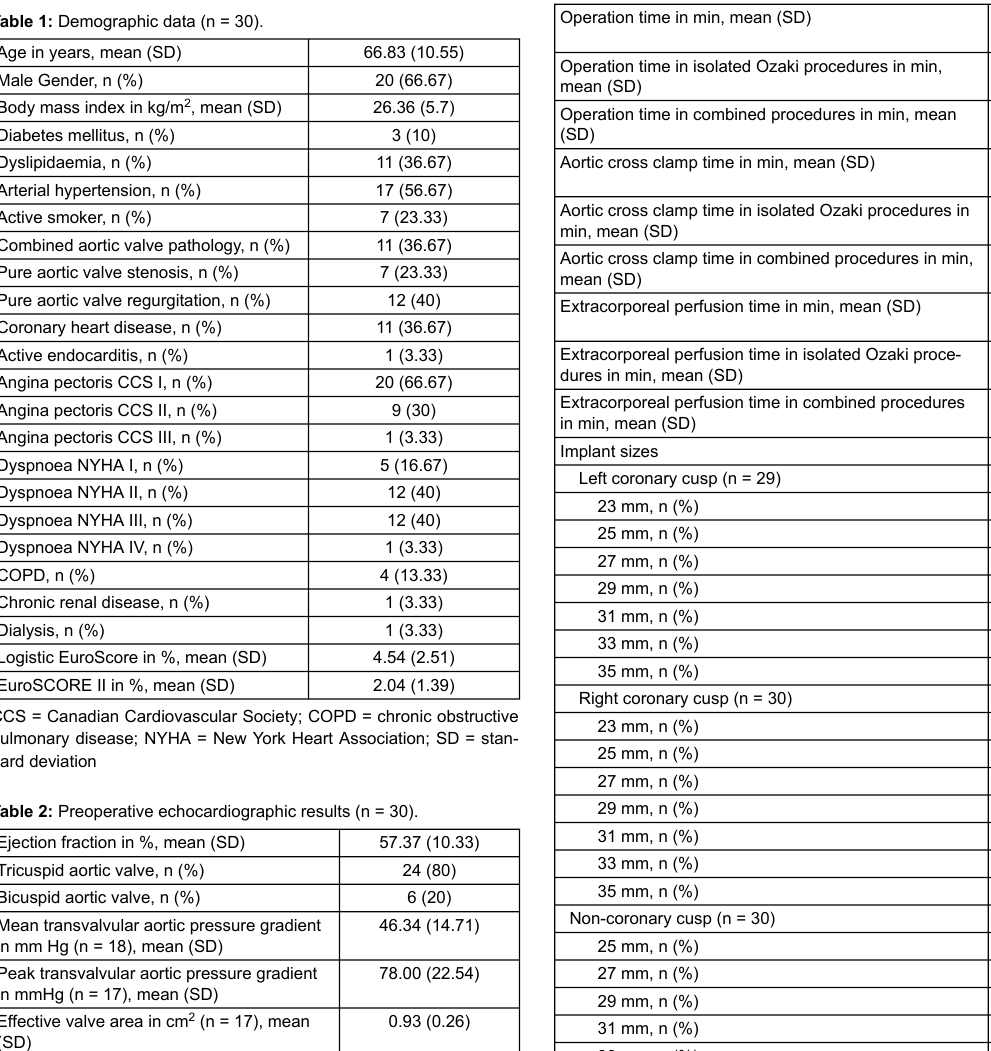
Table 3: Intraoperative data (n =